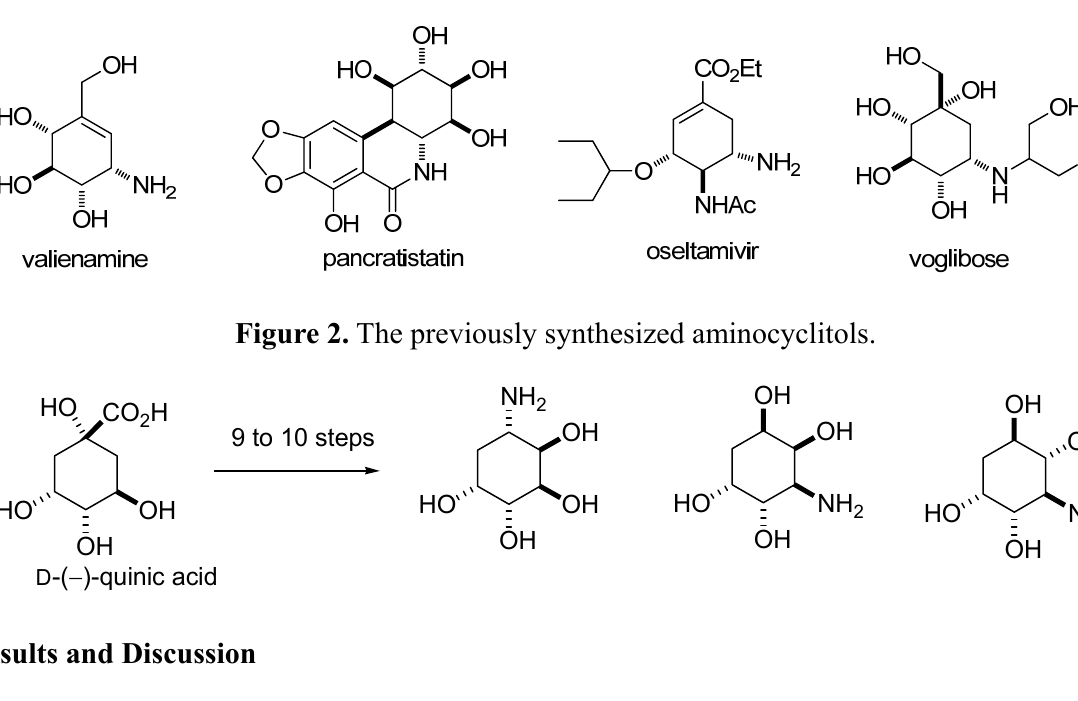
Figure 1. Representative natural or synthetic products containing aminocyclitol moiety.